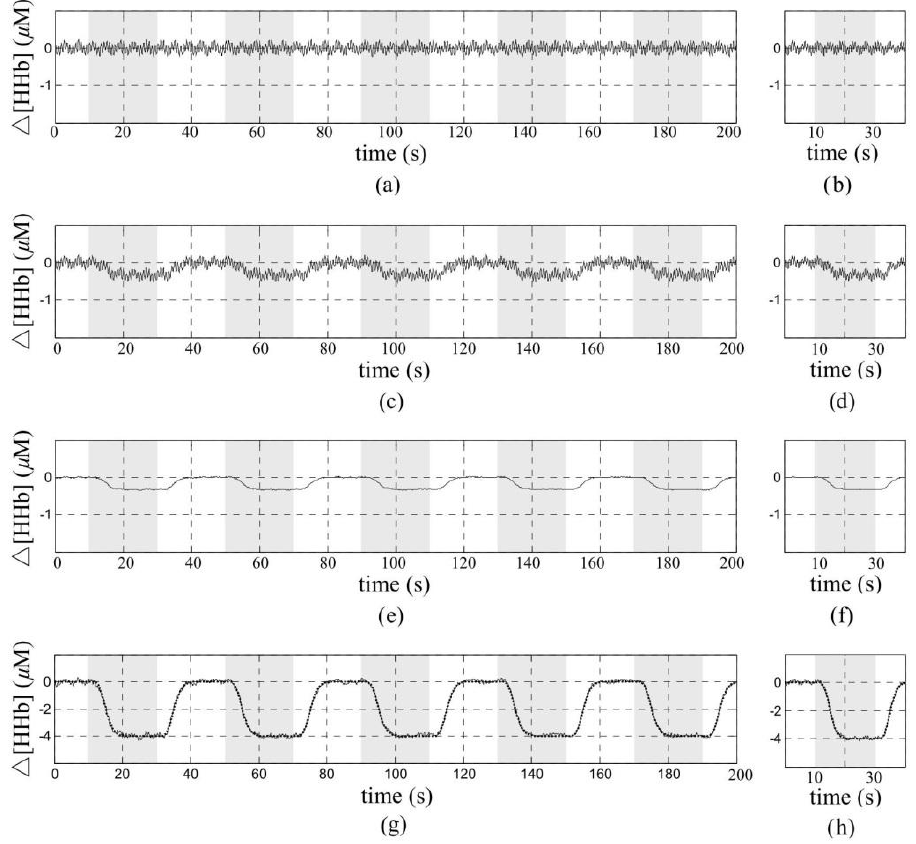
Fig. 5. Concentration changes of HHb extracted with